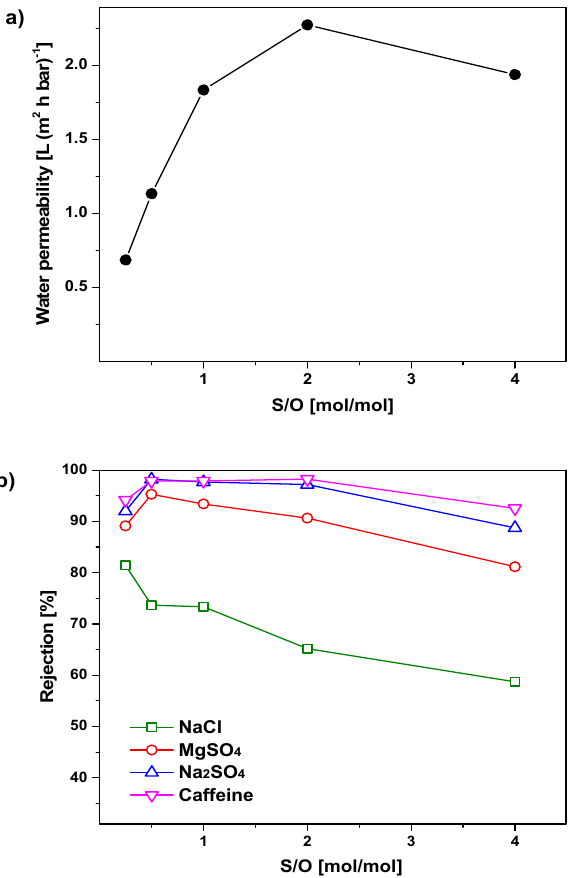
Figure 6. ( a ) Water permeability and ( b ) rejection to salt and caffeine of the 5 mol% Al 2 O 3 -doped silica membranes as a function of the surfactant/oxides (S/O) ratio in the coating sols.